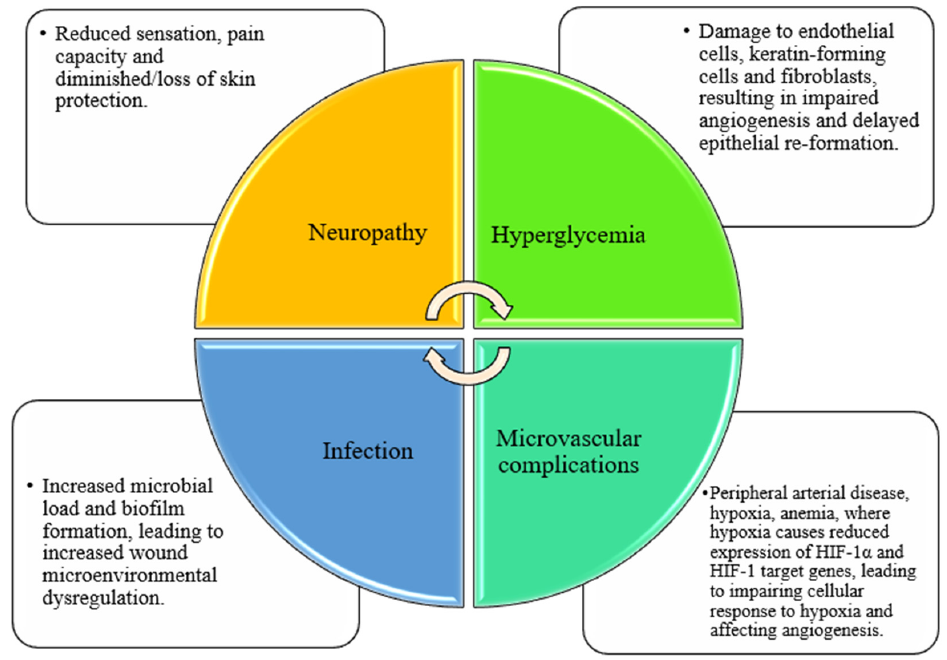
Figure 2. Factors affecting diabetic wound healing, including hyperglycemia, neuropathy, microvascular complications, and infection. Table 1. Advantages and limitations of dressings for the treatment of diabetic wounds